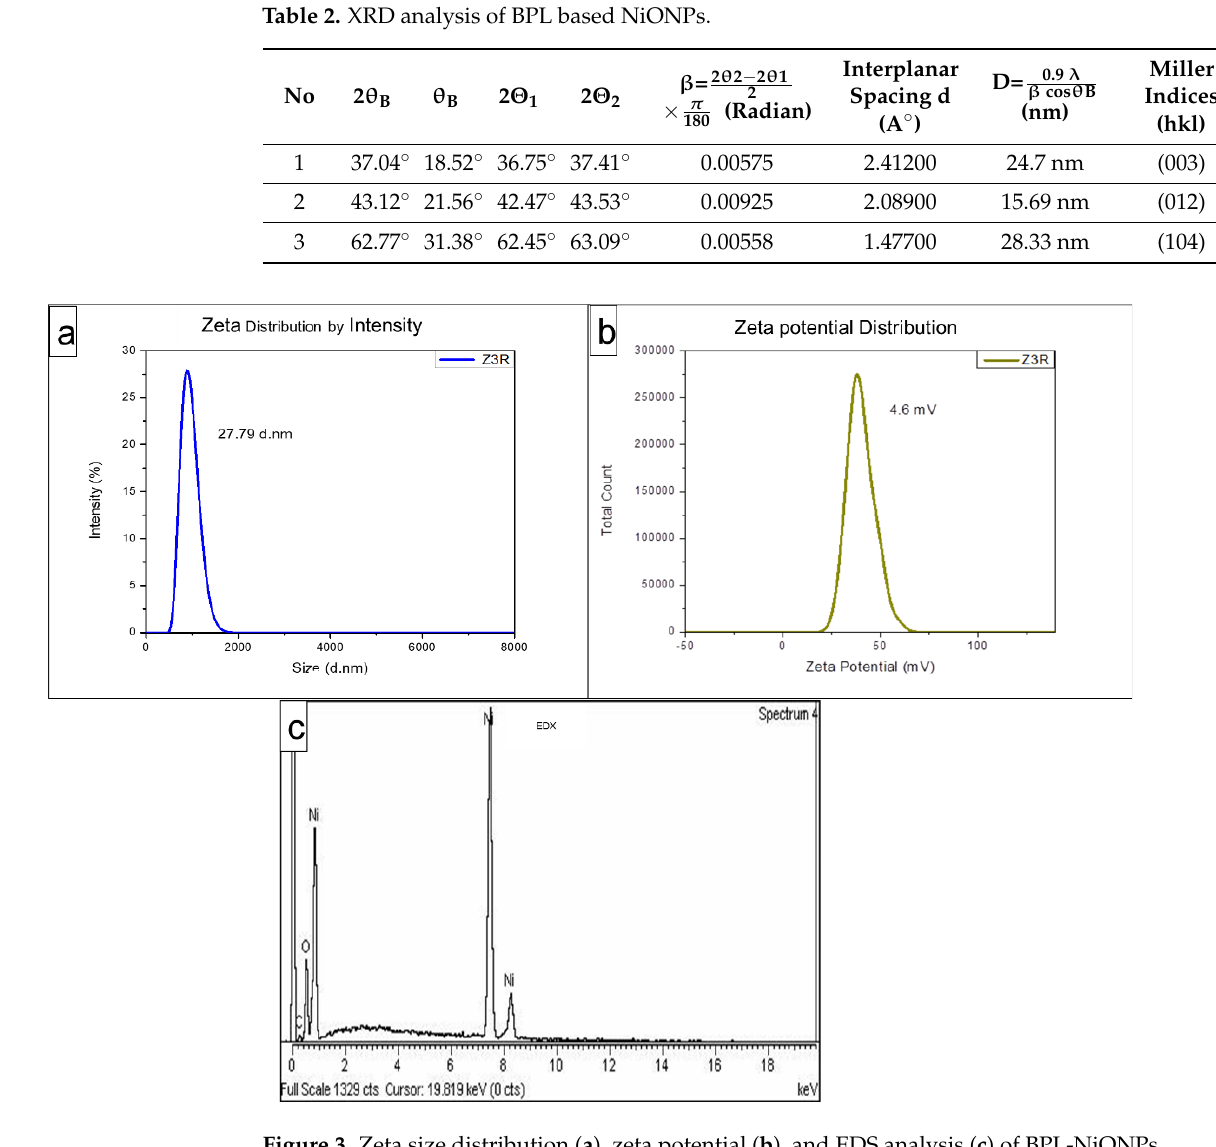
Figure 3. Zeta size distribution ( a ), zeta potential ( b ), and EDS analysis ( c ) of BPL-NiONPs. Table 2. XRD analysis of BPL based NiONPs.